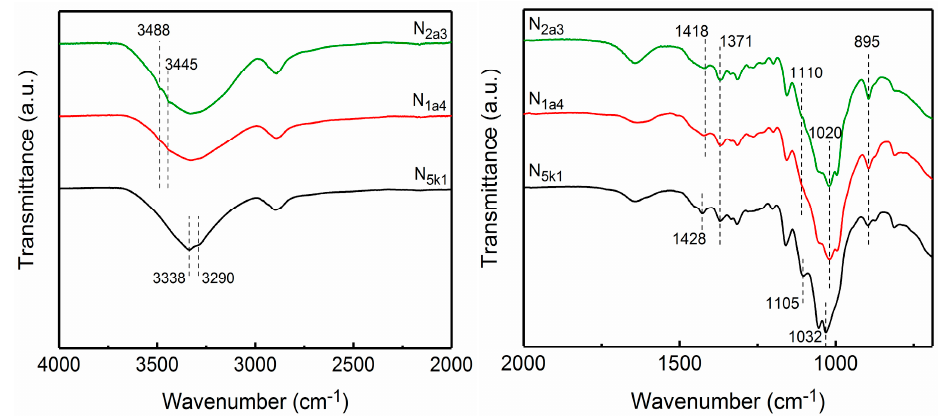
Figure 4. FTIR spectra of the fibrillated CNFs: N 5k1 , N 1a4 , and N 2a3 .